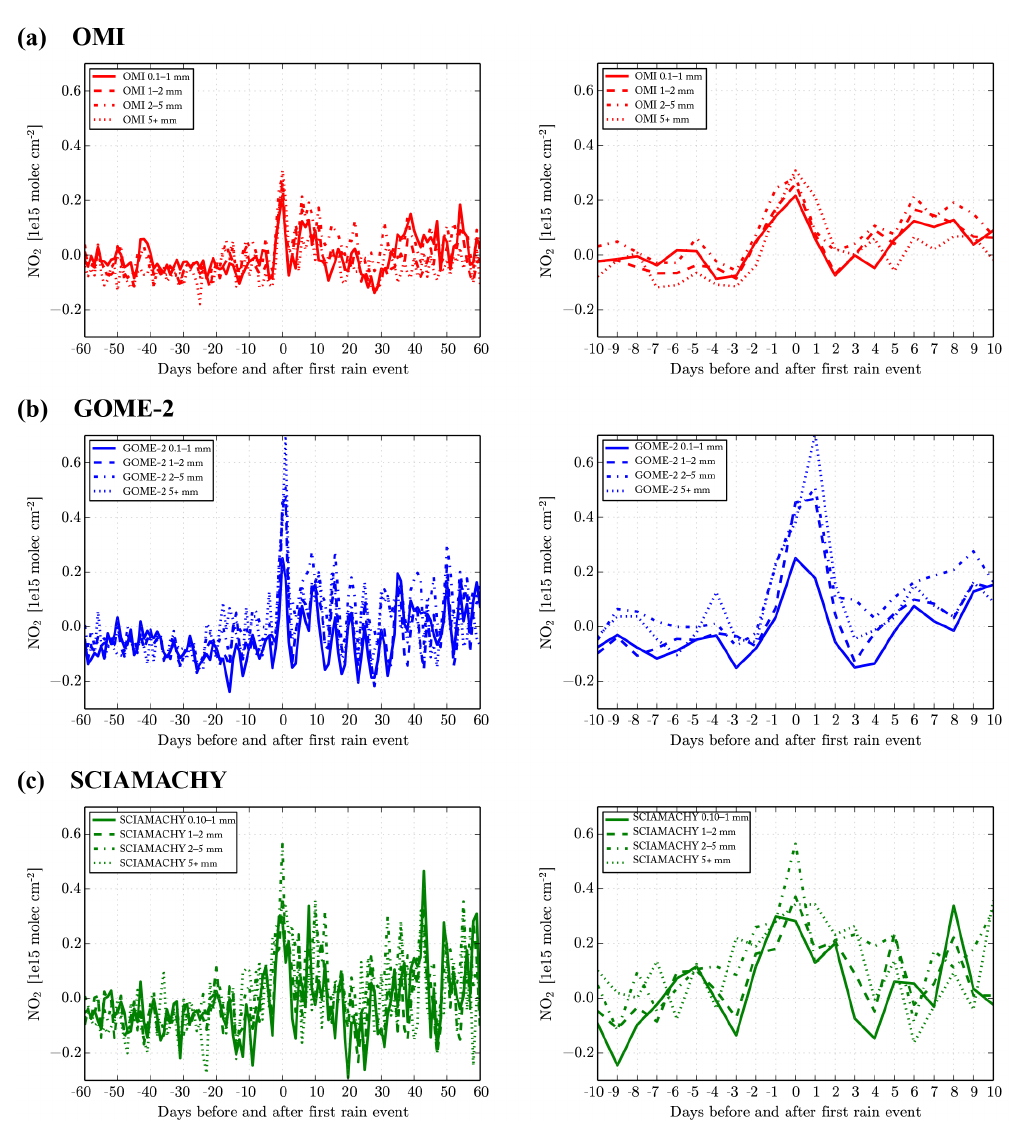
Figure C1. In this figure, NO 2 VCDs are shown from OMI (a) , GOME-2 (b) , SCIAMACHY (c) around the first day of rainfall for the Sahel region for a drought period of at least 60 days. The results are separated for different intervals of the precipitation threshold on Day0. A drought day is defined by precipitation < 0.1mm per day. For better intercomparison, the latitudinal background correction with buffer as described in Sect. 4.5 is applied to each time series individually. The left panels represent the full time series of 60 days before and after Day0, the right panels show a zoom-in for the 10 days before and